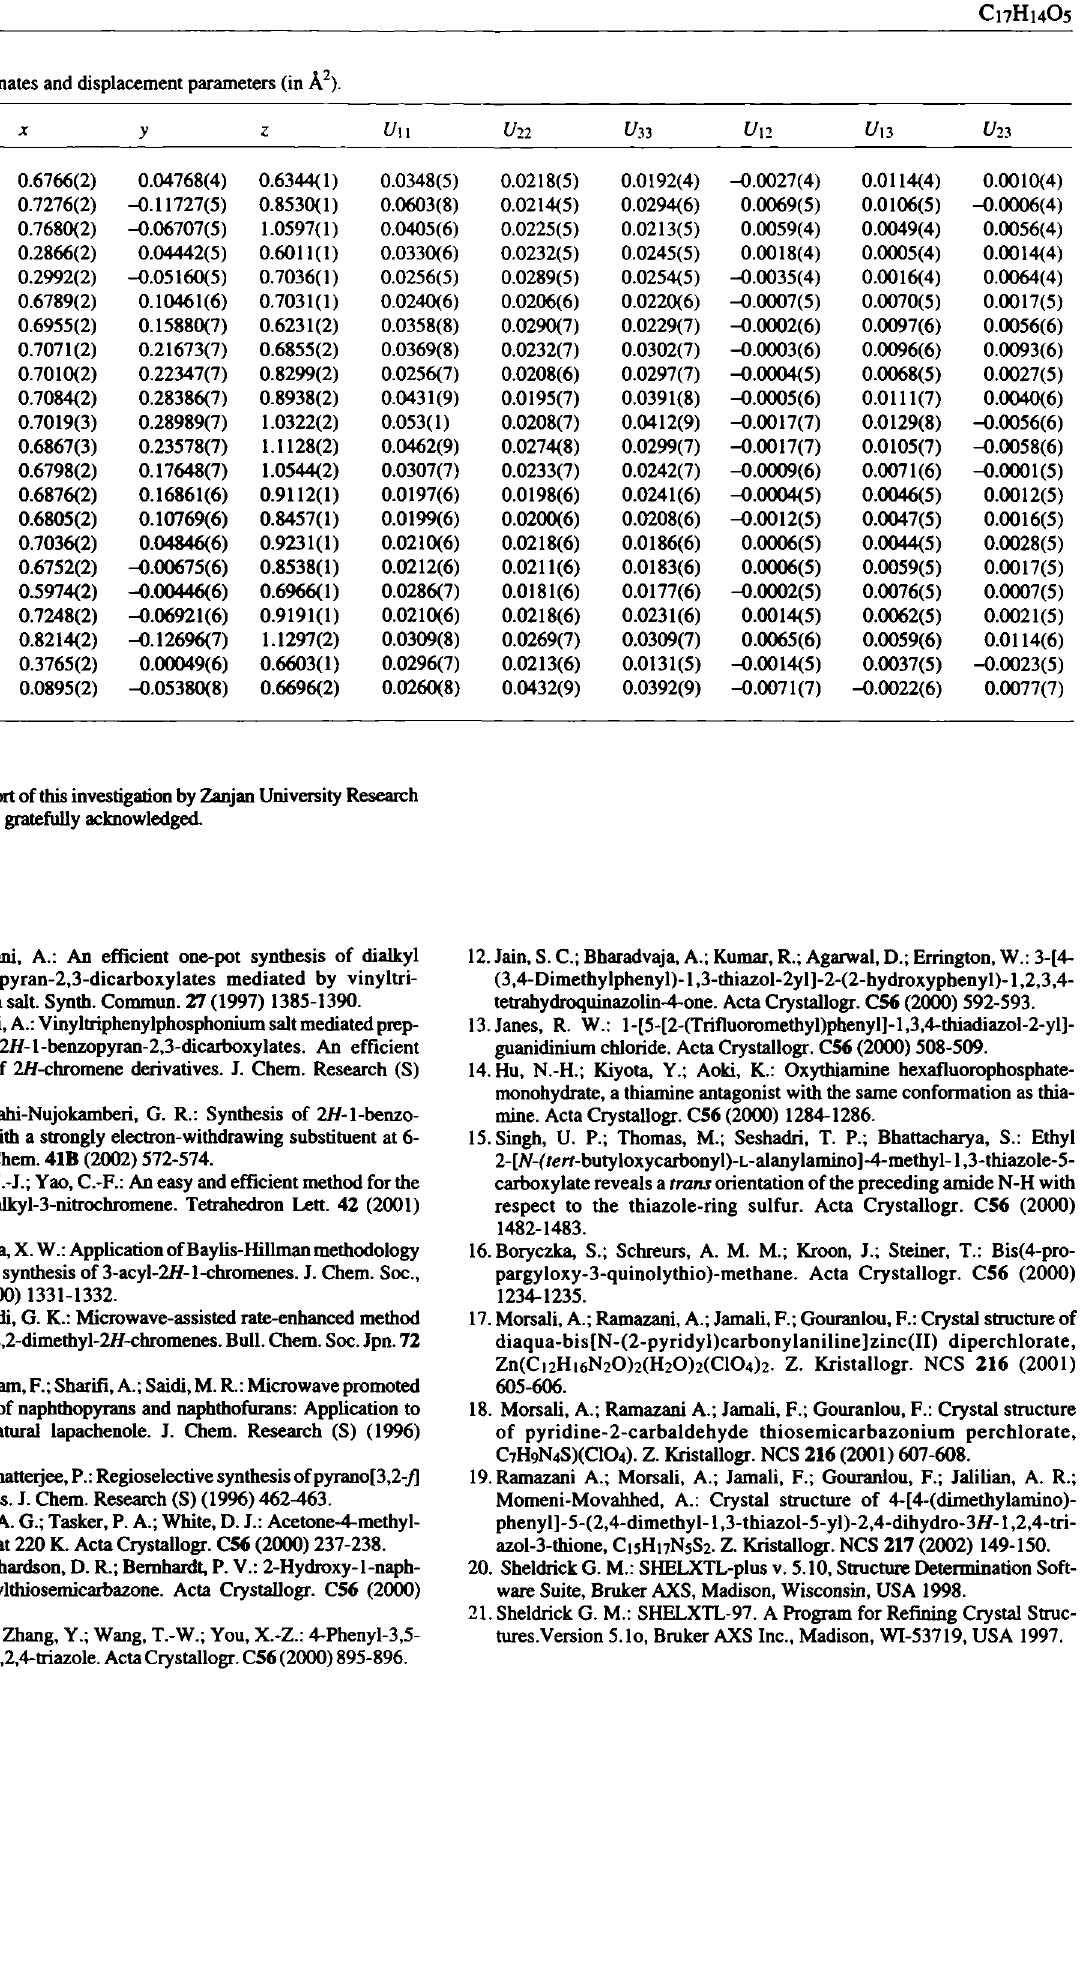
Table 3. Atomic coordinates and displacement parameters (in Â 2